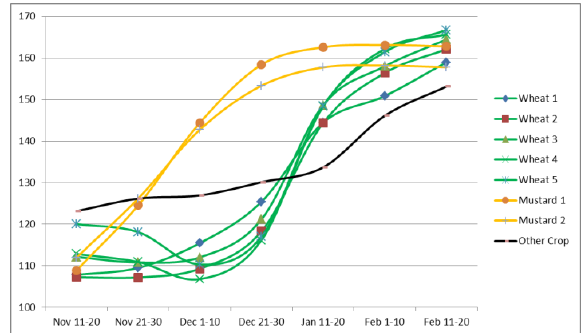
Figure 8: Temporal scaled NDVI [(NDVI+100) *100] pattern of different crops as seen in Resourcesat 2 AWiFS multi-date NDVI data (Yellow: R&M, Green: Wheat, Black: Other Crop) The spectral differences between the crops were used for classifying the crops. A typical R&M classified image is shown in Figure 9, along with the FCC (False Colour Composite) of the Satellite Image, which was used for classifying it. After classifying the crops, the district boundaries were overlaid on the classified maps to generate district level crop area.